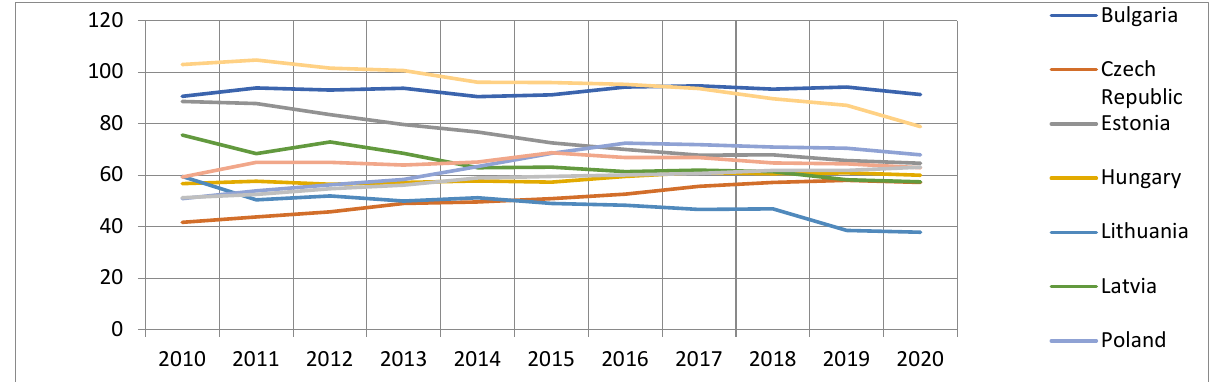
Figure 6. Evolution of automated teller machines (ATMs).